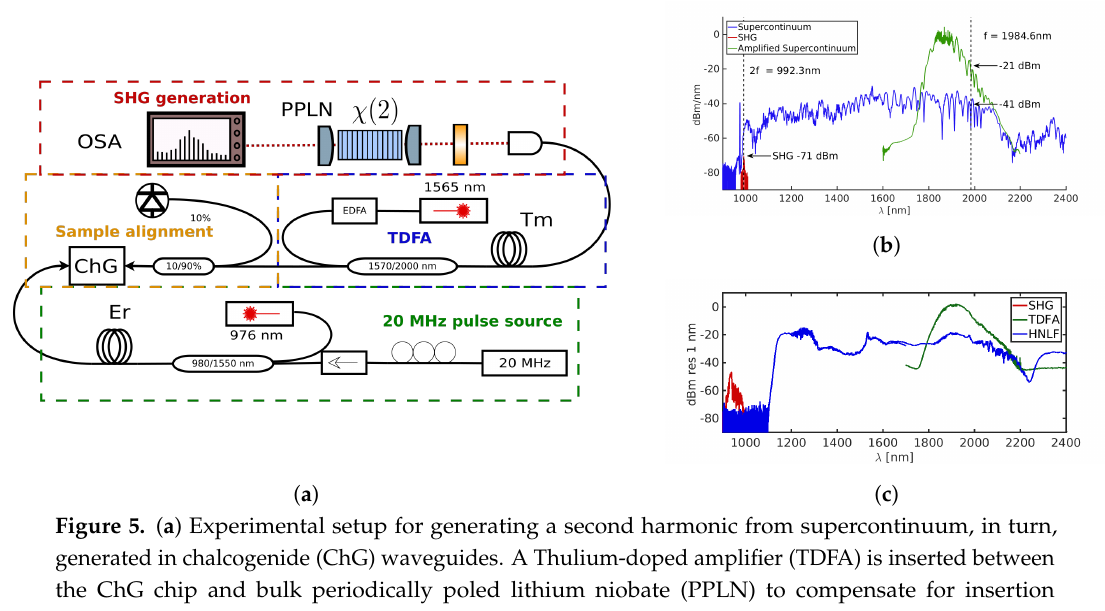
Figure 5. ( a ) Experimental setup for generating a second harmonic from supercontinuum, in turn, generated in chalcogenide (ChG) waveguides. A Thulium-doped amplifier (TDFA) is inserted between the ChG chip and bulk periodically poled lithium niobate (PPLN) to compensate for insertion losses. ( b ) The measured spectra in the experiment: blue—supercontinuum generated from ChG, green—amplified supercontinuum, red—second harmonic. ( c ) The same experiment performed with highly nonlinear fiber and thin-film lithium